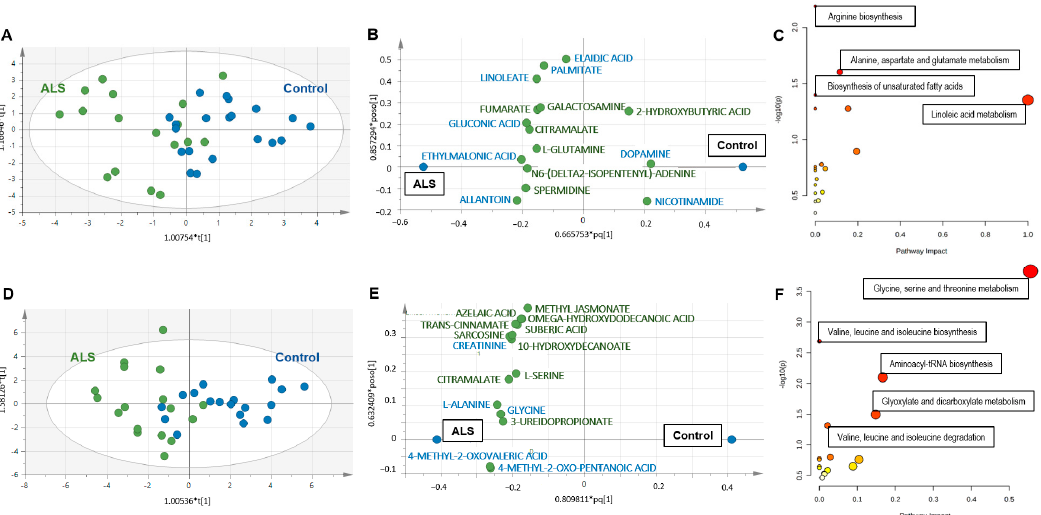
Figure 1. ( A – C ) Metabolomics analysis of serum from ALS and controls. ( A ) Score scatter plot based on the OPLS-DA models from serum to explain the diagnosis, with R2X = 0.452, R2Y = 0.477, Q2 = 0.269 and p < 0.035 for the CV-ANOVA test (blue: controls; green: ALS). ( B ) Loading scatter plot presenting the top 15 metabolites identified by the OPLS-DA. The horizontal axis displays the X-loadings p and the Y-loadings q of the predictive component. The vertical axis displays the X-loadings p(o) and the Y-loadings s(o) for the Y-orthogonal component. X-variables situated in the vicinity of the dummy Y-variables have the highest discriminatory power between the classes. The eight metabolites that had VIP scores higher than 1 are written in blue. ( C ) Pathway analysis with the 15 VIP metabolites highlighted alterations in arginine biosynthesis ( p = 0.006), alanine, aspartate and glutamate metabolism ( p = 0.02), biosynthesis of unsaturated fatty acids ( p = 0.04) and linoleic acid metabolism ( p = 0.04). Each node represents a metabolite set with its color based on its p -value and its size based on the pathway impact. The complete list of metabolic pathways is described in Supplementary File S4. ( D – F ) Metabolomics analysis of muscle from ALS and controls. ( A ) Univariate volcano plot analysis revealed different metabolites in the muscle metabolome from ALS patients and control subjects. Metabolites identified on the left are decreased in ALS patients compared to controls, while metabolites on the right of the diagram are increased in ALS patients. ( B ) Score scatter plot based on the OPLS-DA models from muscle to explain the diagnosis, with R2X = 0.76, R2Y = 0.555, Q2 = 0.446 and p < 0.0012 for the CV-ANOVA test (blue: controls; green: ALS). ( C ) Loading scatter plot presenting the top 15 metabolites identified by the OPLS-DA. The five metabolites that had VIP score higher than 1 are written in blue. ( D ) Pathway analysis with the 15 VIP metabolites highlighted alterations in the metabolism of glycine, serine and threonine ( p < 0.001); biosynthesis ( p = 0.002) and degradation ( p = 0.04) of valine, leucine and isoleucine; aminoacyl-tRNA biosynthesis ( p = 0.007) and glyoxylate and dicarboxylate metabolism ( p = 0.03). The complete list of metabolic pathways is described in Supplementary File